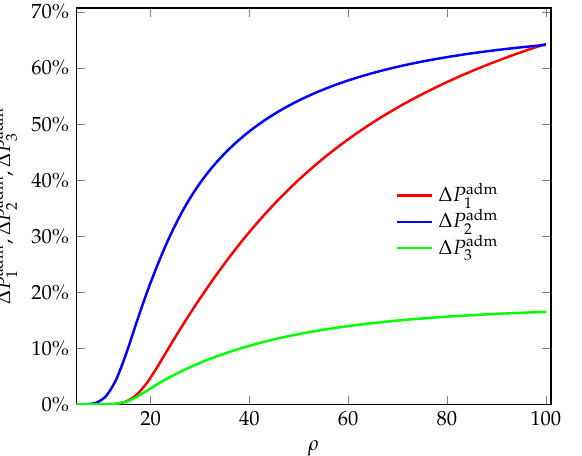
Figure 7. The percentage increase in the admission probabilities for arriving requests vs. the offered load.